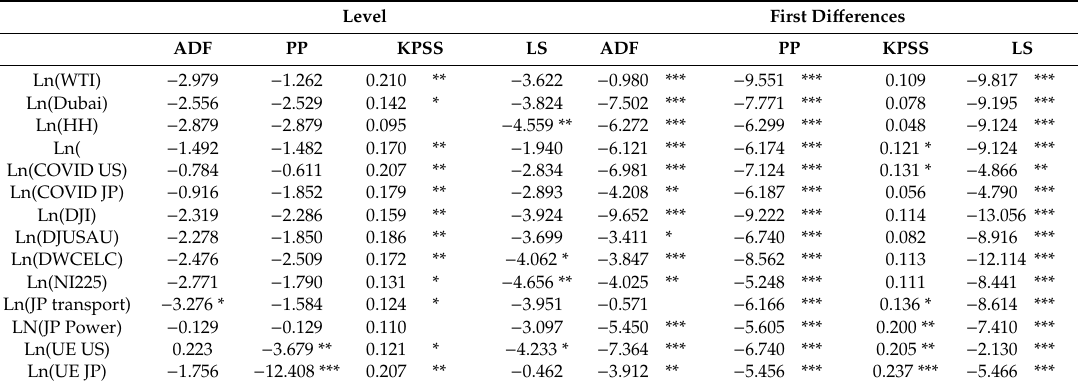
Table 4. Unit root